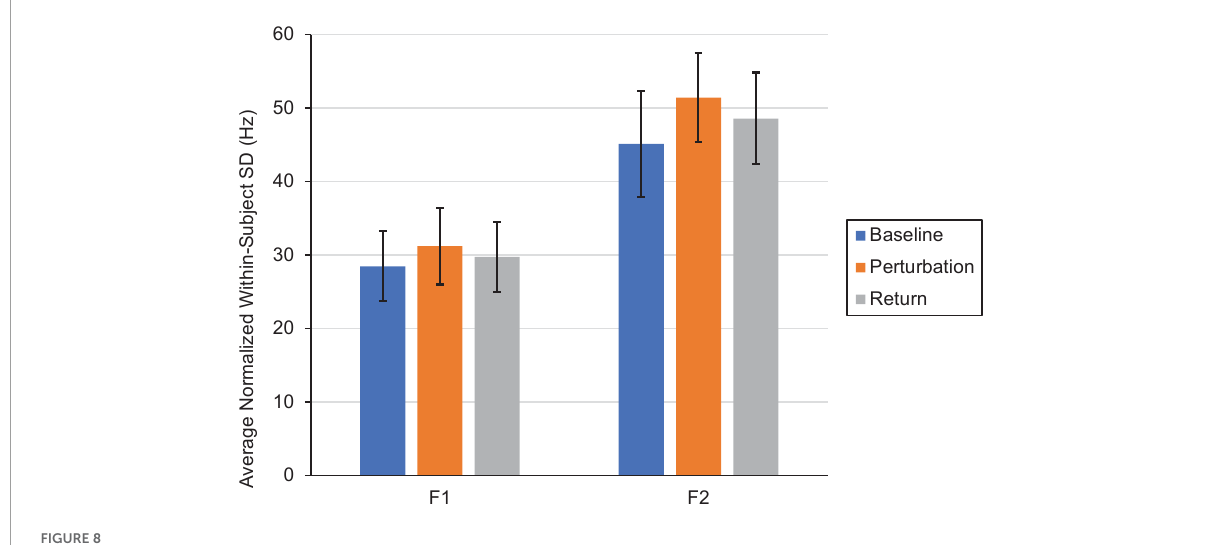
FIGURE8 Average normalized F1 and F2 within-subject variability (i.e., SD) in the Baseline (blue), Perturbation (orange), and Return (gray) phases of Experiment 2. Error bars represent 95% confidence intervals.